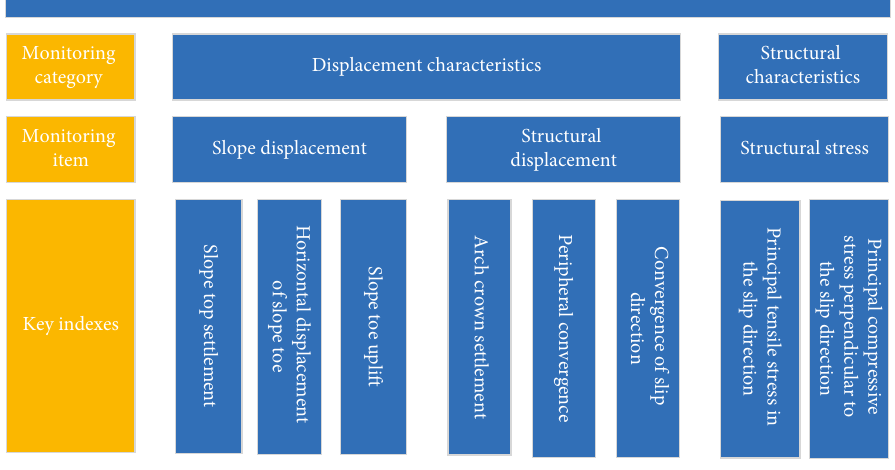
Figure 19: Monitoring index